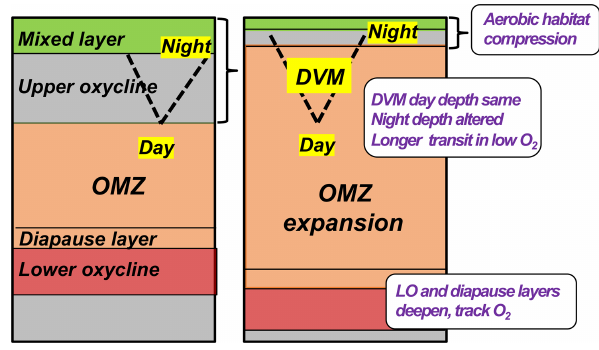
Figure 11. Schematic illustration of OMZ expansion effects on zooplankton distributions. The bracket indicates the most aerobic habitat of the water column (mixed layer plus upper oxycline). The dashed line represents diel vertical migration. The layer of diapaus- ing E. inermis is shown just above the lower oxycline. This figure updates earlier depictions (Seibel, 2011; Wishner et al., 2013; Seibel and Wishner, 2019) with new information from this